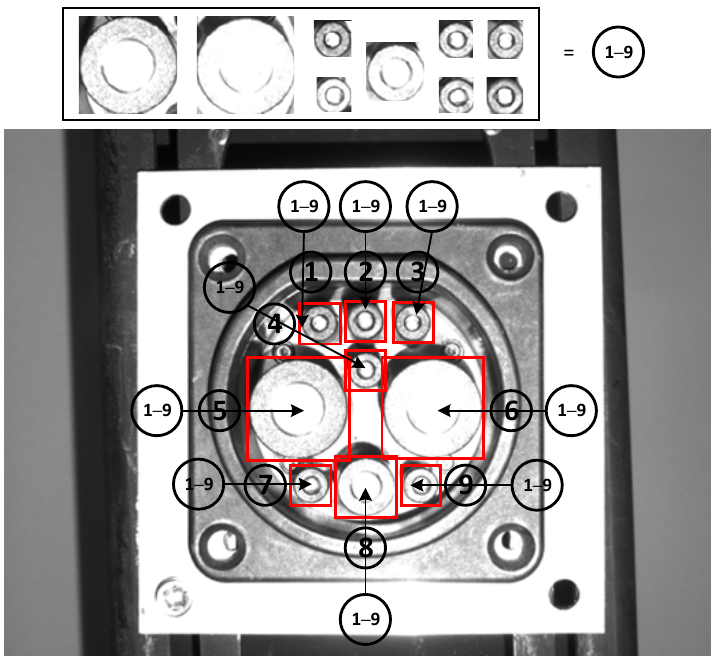
Figure 4. Feature data enhancement method.